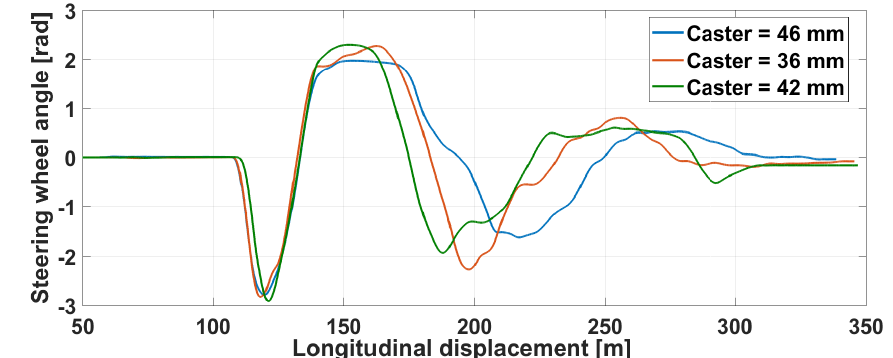
Figure 29. Haptic steering wheel: angle with various caster.